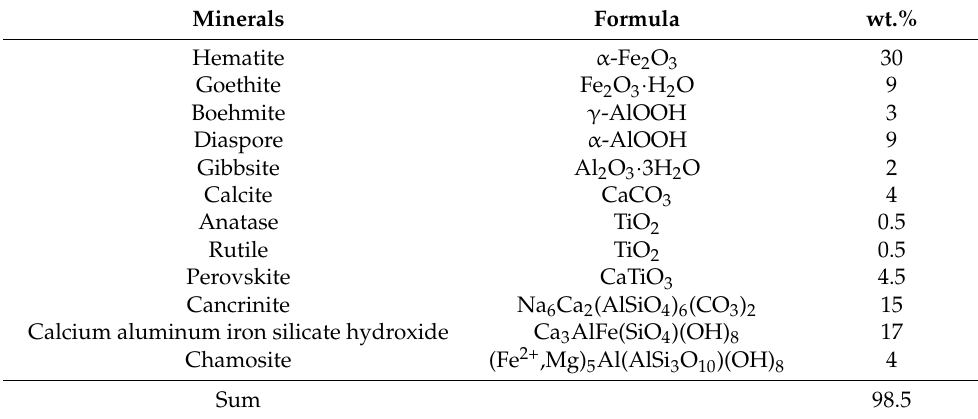
Table 2. Bauxite residue mineralogical